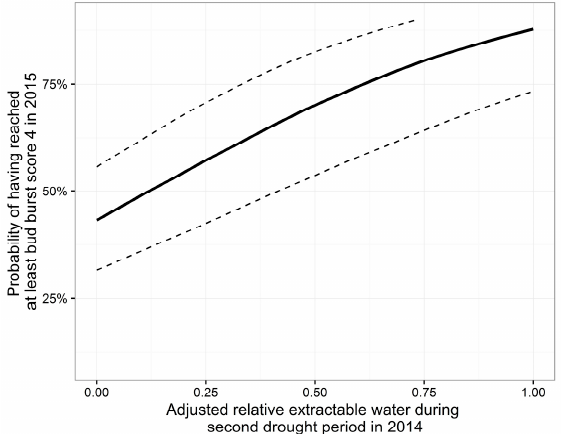
Figure 3. Modelled probability of having reached at least bud burst score 4 (leaves protruding from the apical bud) depending on the adjusted relative extractable water of the pots during the second drought period in the first growing season; 95% confidence intervals are shown with dashed lines.